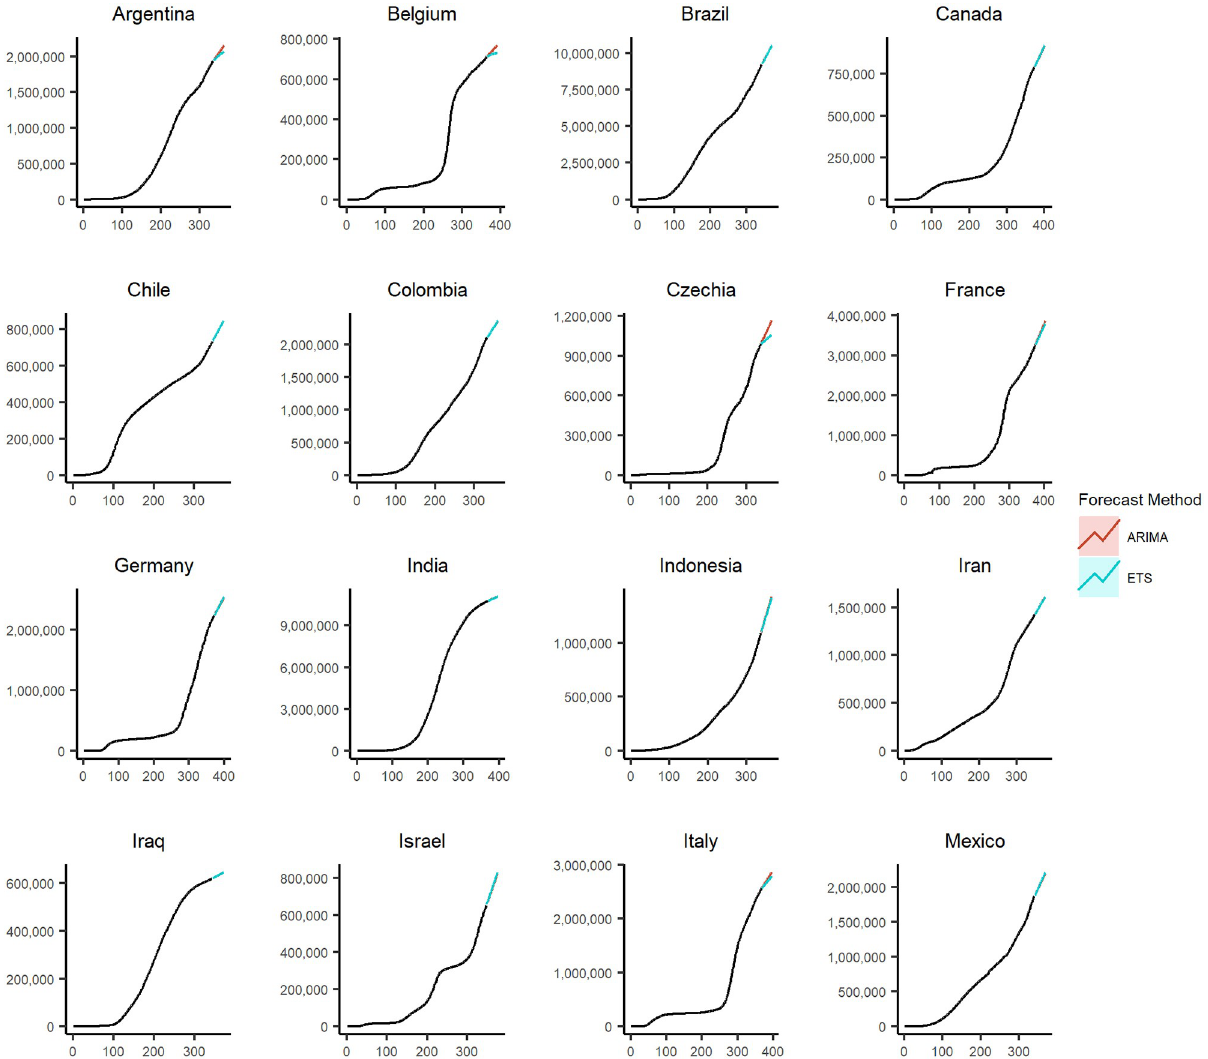
Fig 5. The 4 weeks ahead forecasts for 16 of the 29 countries with the highest cumulative COVID-19 cases.